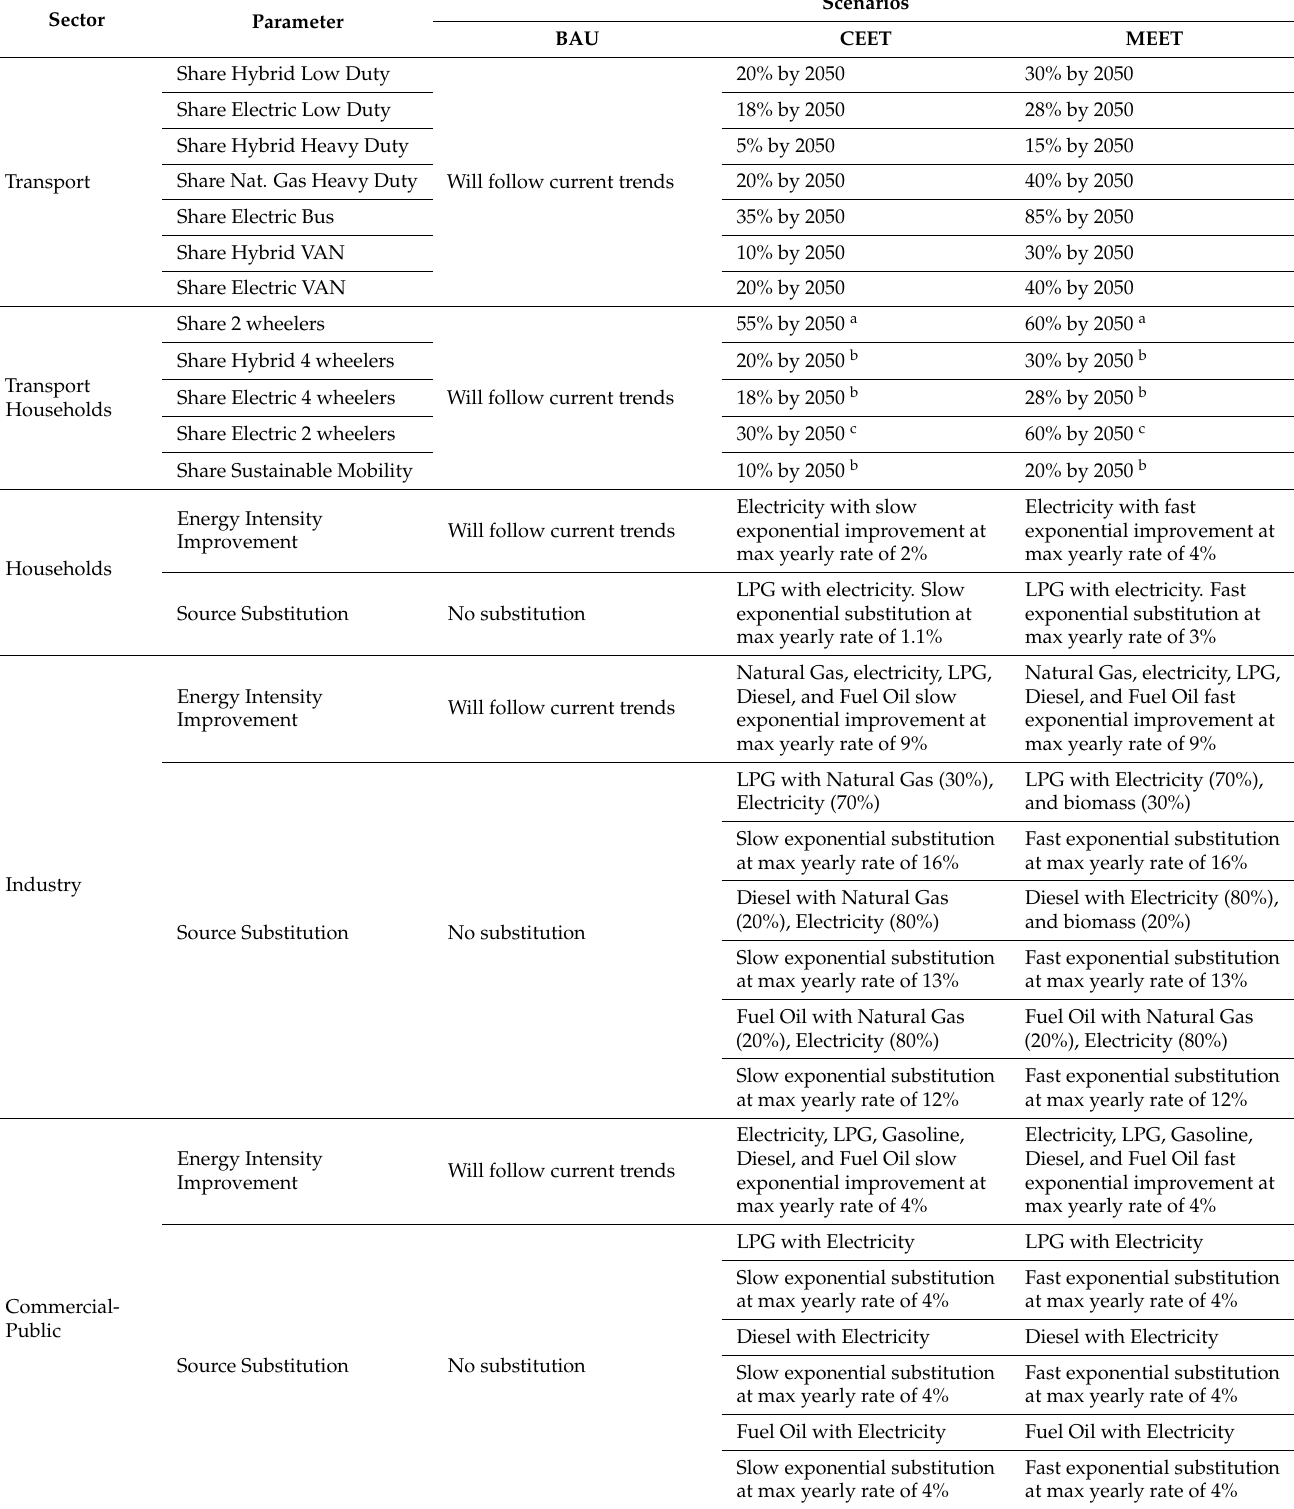
Table 2. Scenario main